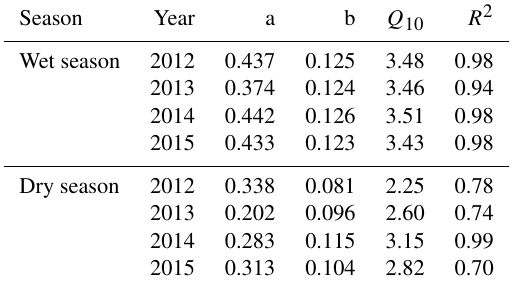
Table 3. The ecosystem respiration parameters using Eqs. (2) and (3) (a: µmolm − 2 s − 1 , b: Q 10 , R 2 ) for the wet and dry sea- sons from 2012 to 2015. The regression was based on the average values of RE and T soil with T soil bins of 1 ◦ C.